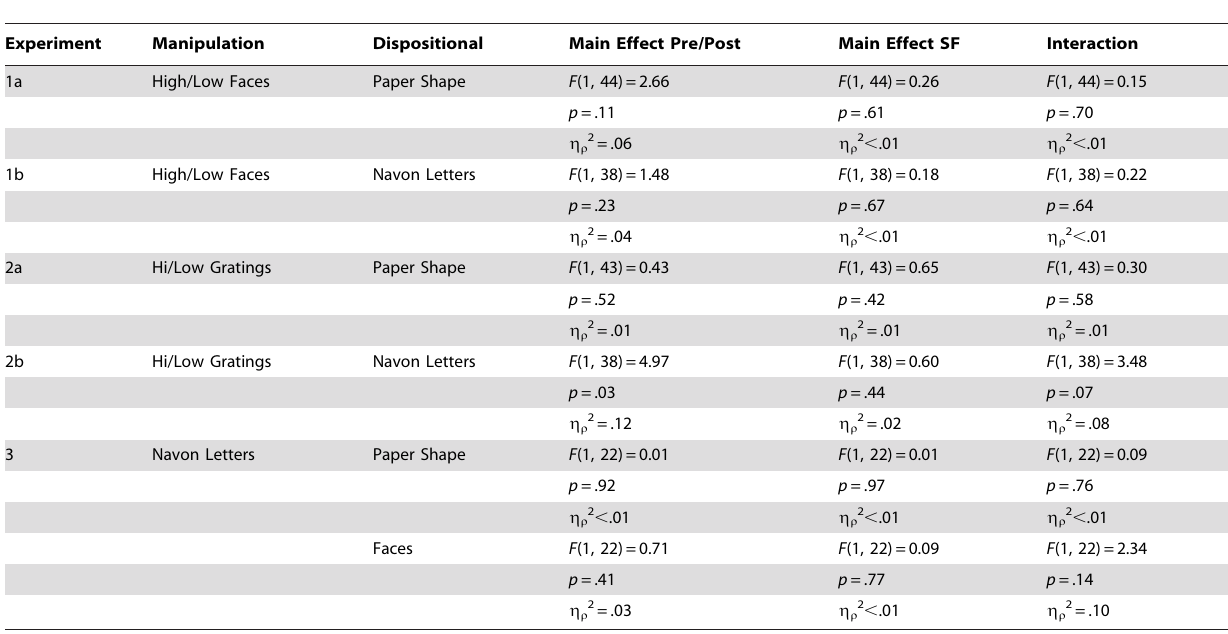
Table 1. Manipulation tasks, dispositional tasks, and ANOVA results for each